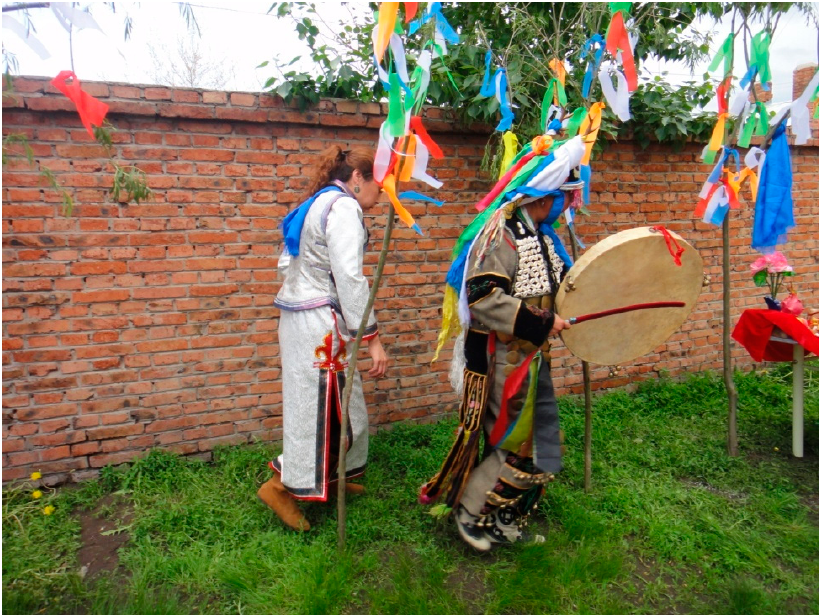
Figure A2. Wo Jufen Shaman leads the candidates to run back and forth on a path in the shape of an 8, along the nine trees, leading the bar ʃ ancestor’s ʊ ŋ ɡ ʊ r (On 14 June 2013, Lina’s initiation ritual as jad’ ə n and bar ʃ ). Photo: Minna Sa, 2013.